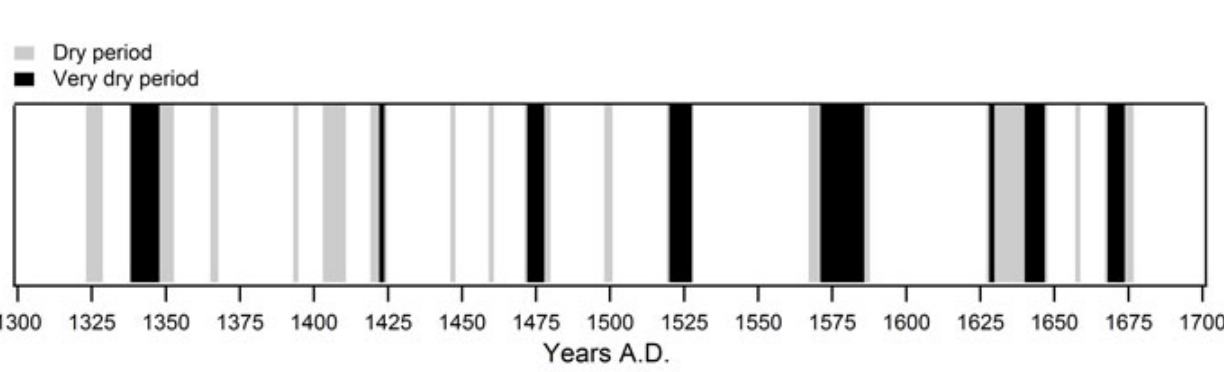
Fig. 6 . Salinas climatic